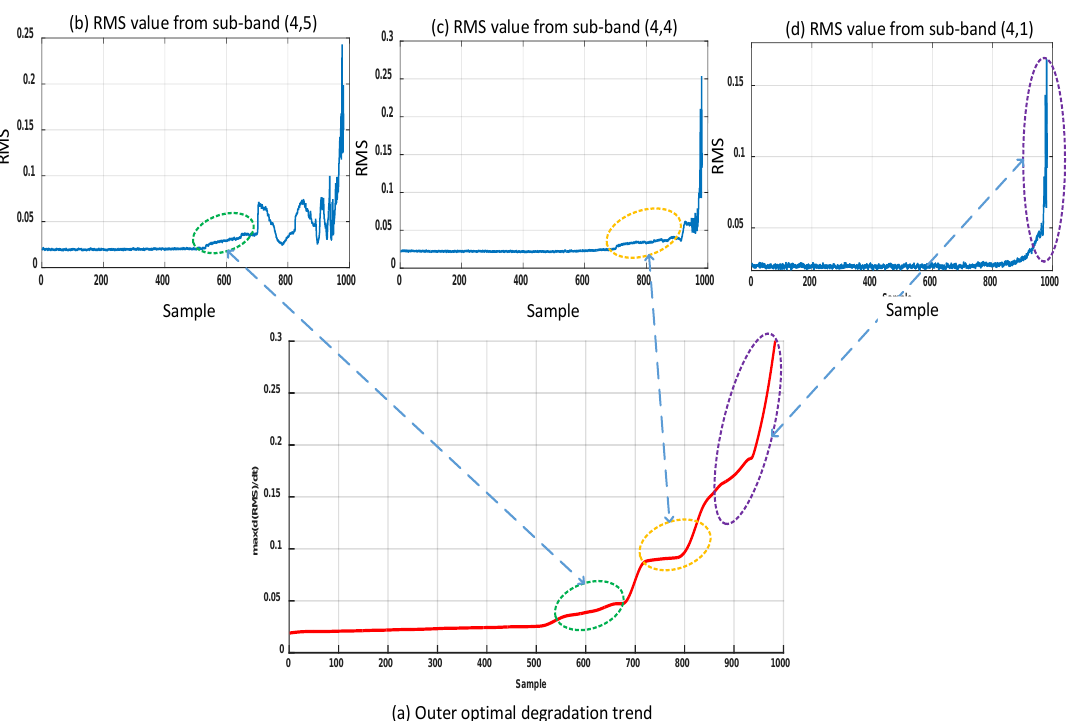
Figure 4. Process of accumulating the best trends in the RMS values from different sub-bands for bearing 1 of the second run-to-failure test of the IMS dataset, which failed owing to an outer race failure: ( a ) Outer optimal degradation trend, ( b ) RMS value from sub-bands (4,5), ( c ) RMS value from sub-band (4,4), ( d ) RMS value from sub-bands (4,1).